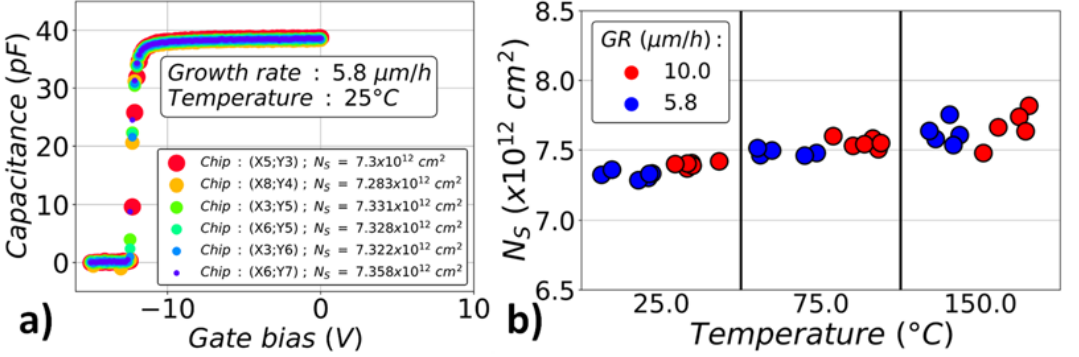
Figure 3. ( a ) Capacitance versus voltage measurement of Gated Van Der Pauw structure. ( b ) Extracted electron density as a function of the temperature for two different growth rates.